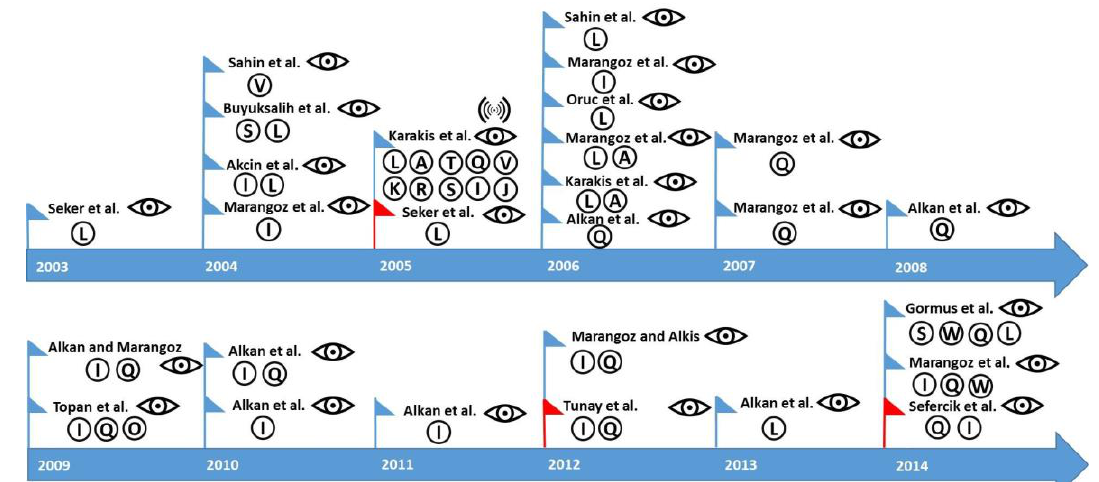
Figure 6. Summary of previous studies of object recognition.